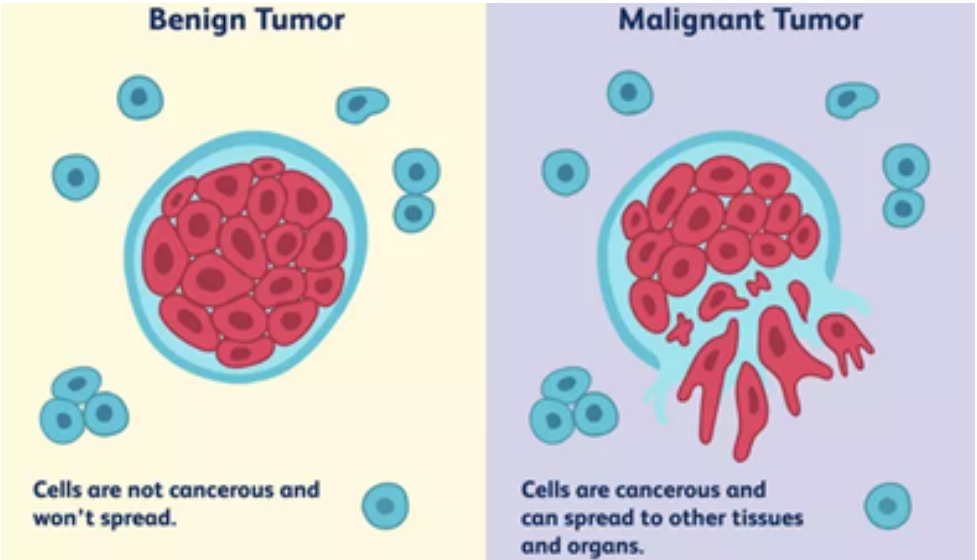
Figure 4. Types of